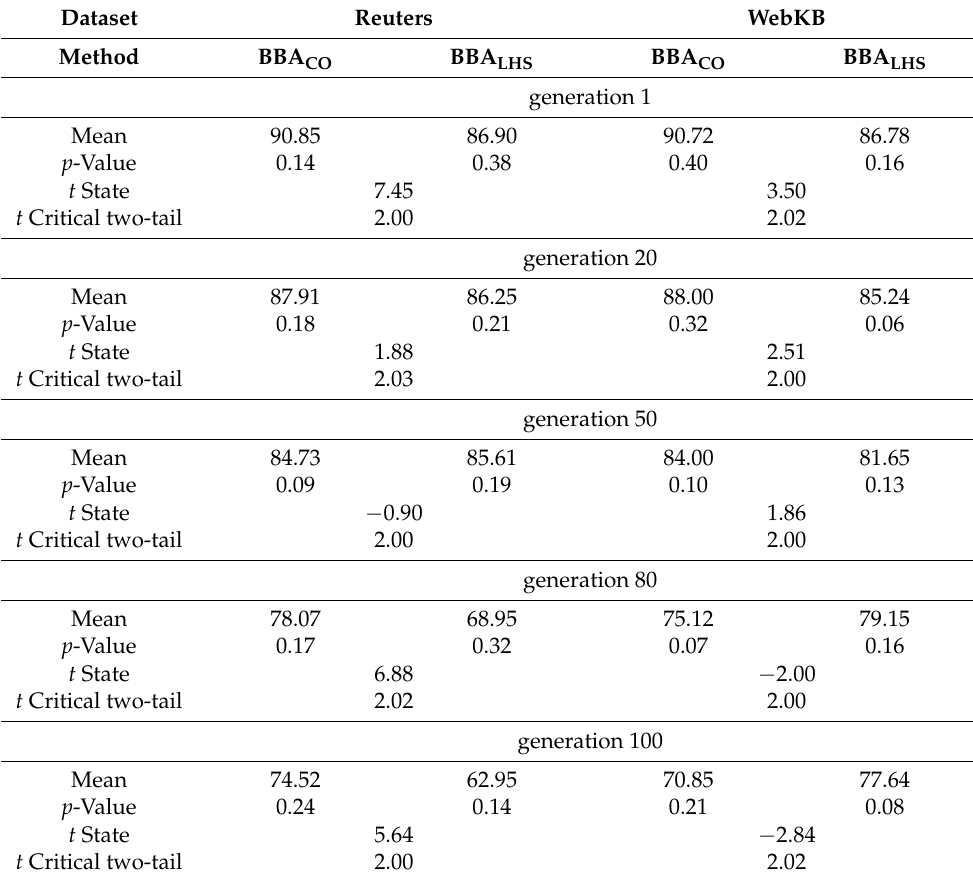
Table 6. The t -test of ARE in different generations using BBA CO and BBA LHS .